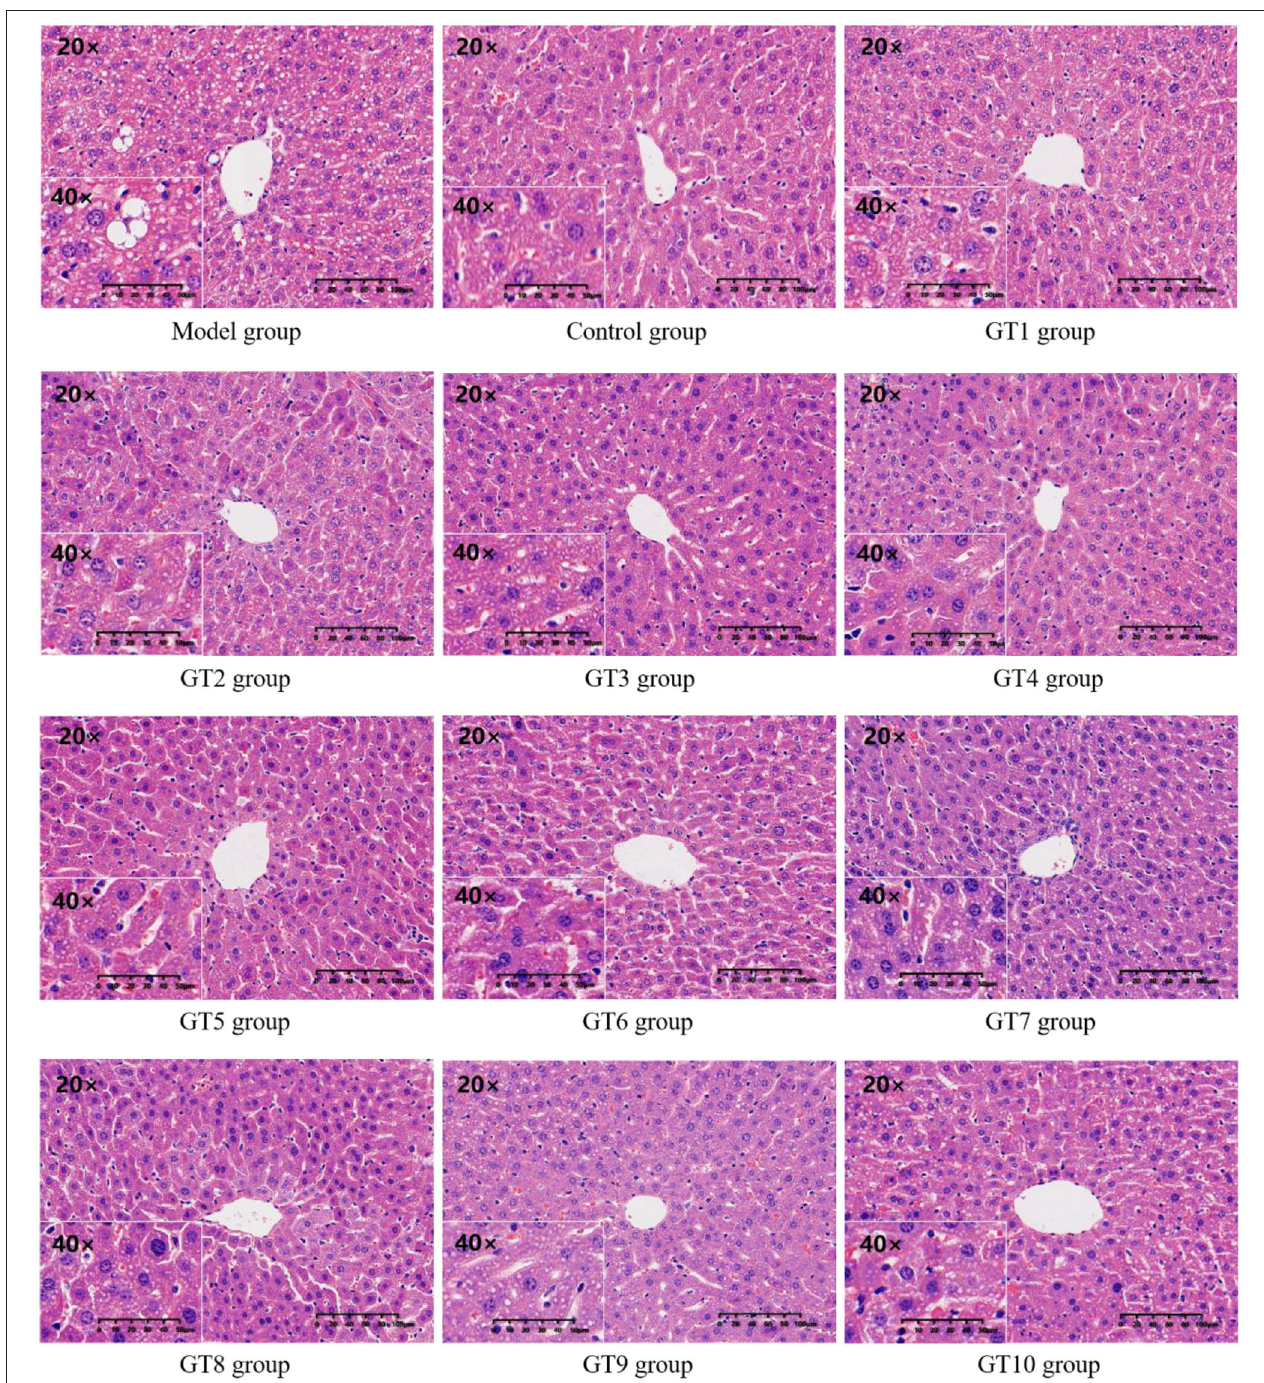
FIGURE 6 | The histopathological images of hepatic tissue (200 and 400X magnification). GT1, Dianqing Tea; GT2, Jieyang Chaoqing Tea; GT3, Fenggang Zinc-Selenium-Enriched Tea; GT4, Liping Xiang Tea; GT5, Taiping Houkui Tea; GT6, Xihu Longjing Tea; GT7, Chaoqing Green Tea; GT8, Selenium-Enriched Chaoqing Green Tea; GT9, Selenium-Enriched Matcha; GT10, Seven Star Matcha.